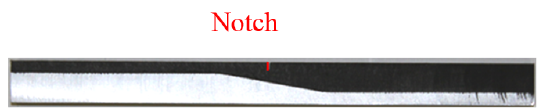
Figure 3: Specimen of composite material (CFRP & A2017).